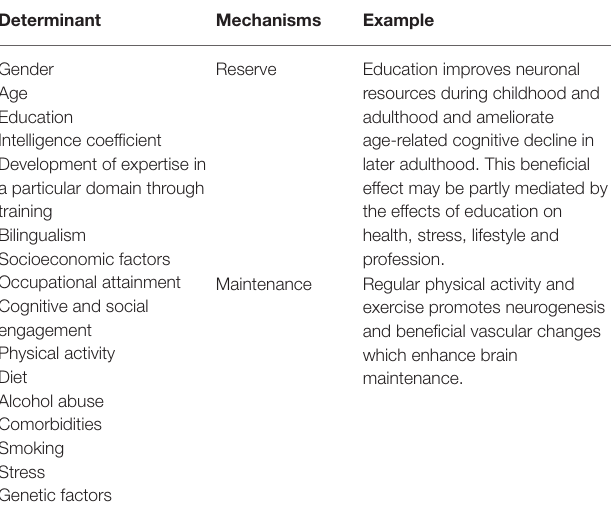
TABLE 1 | Examples of potential determinants of the inter-individual variability in cognitive decline.